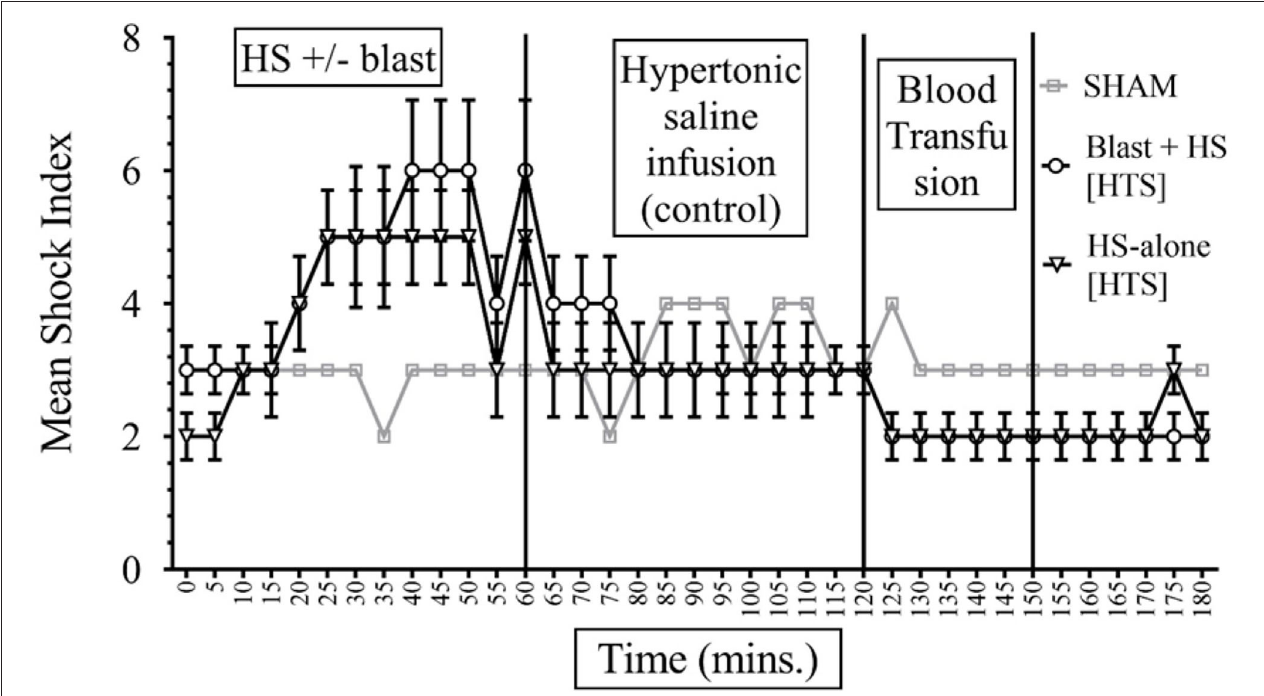
FIGURE 4 | Shock Index (SI) in HS + / − blast injury animals with hypertonic saline (7.5% saline) infusion. Results are in mean ± SE, eight animals per group. SI was higher in the combined injury group in comparison to the HS-alone group after the injury. Hypertonic saline resuscitation decreased the SI to or near the baseline